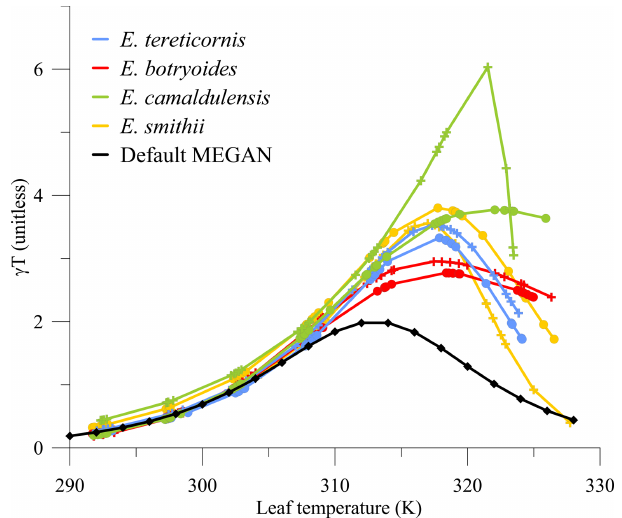
Figure 2. Comparison of γT with leaf temperature calculated us- ing default values in MEGAN to results from four eucalypt tree species under current-climate (filled circles) and future-climate ( + sign) growth